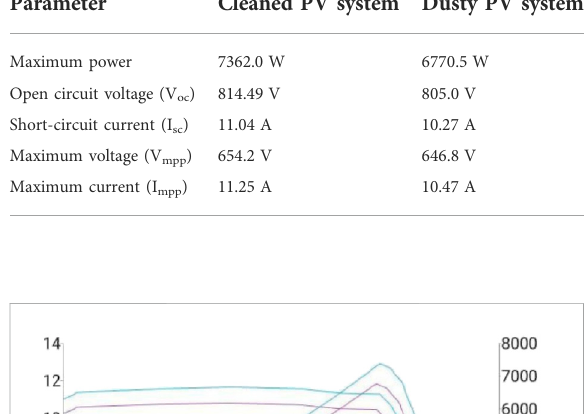
TABLE 10 Parameters of the photovoltaic systems for the January.